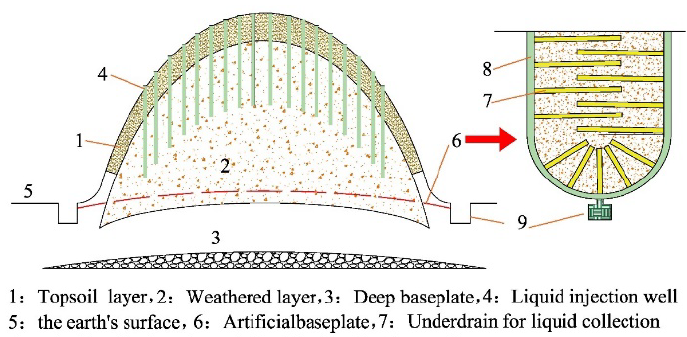
Figure 12. Schematic diagram of fully covered ionic rare earth mine artificial baseplate concealed ditch net liquid collection method.